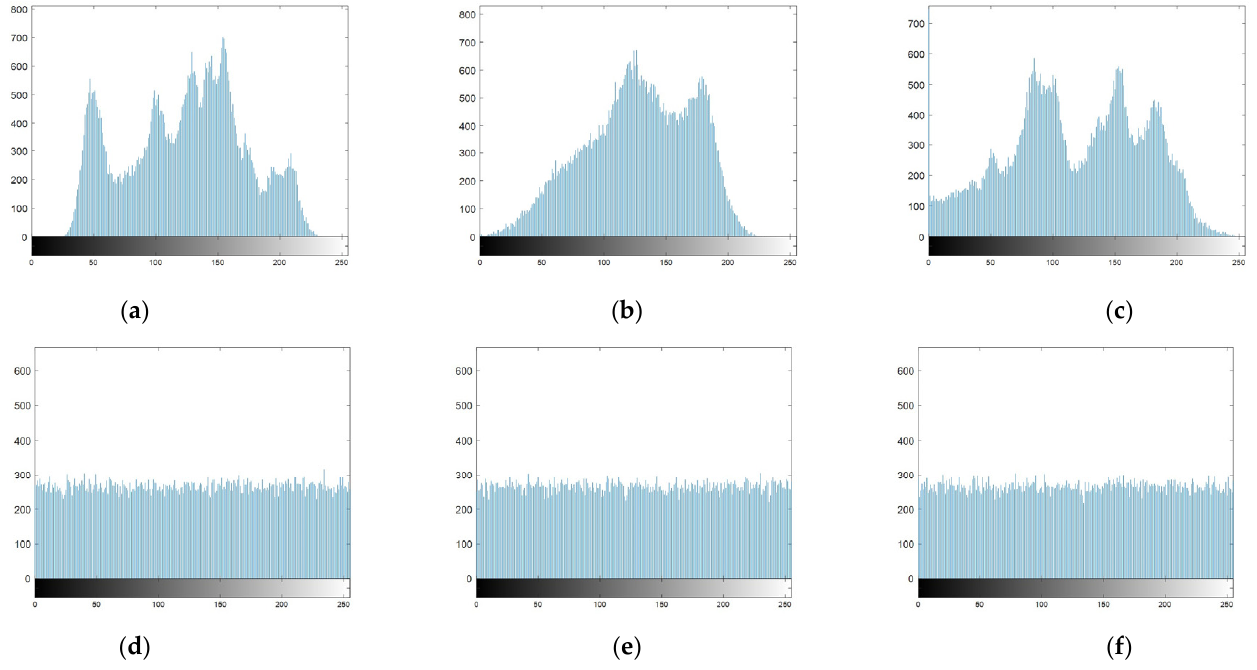
Figure 10. Simulation results (512 ∗ 512 and irregular): ( a – d ) original images; ( e – h ) encrypted im ‐ ages; ( i – l ) decrypted images.